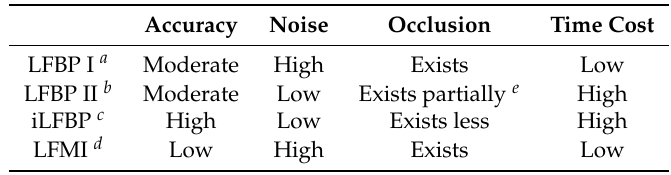
Table 1. Comparison of light ray field reconstruction